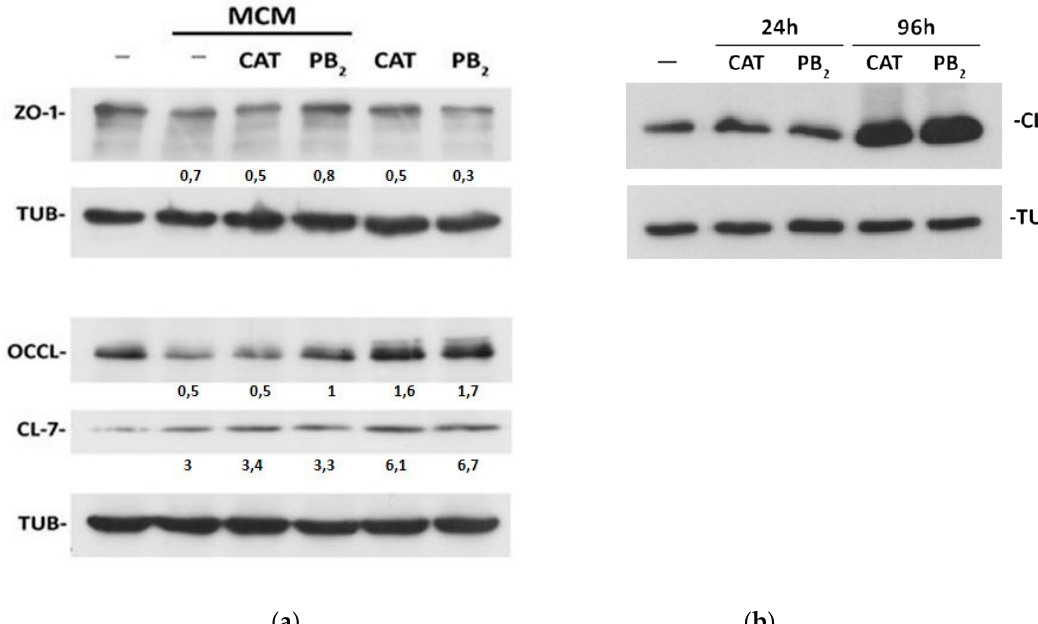
Figure 2. Expression of tight-junctions proteins in Caco-2/HT29-MTX monolayers. Cell monolayers were incubated for 24 h in plain growth medium or with CAT or PB 2 (50 µM), added at the apical side. (a) The basolateral medium was then replaced with MCM or with the medium of Raw264.7 cultures not treated with LPS (See Methods), and the incubation prolonged for further 72 h. Protein were extracted and the expression of ZO-1, occludin and claudin-7 was determined. (b) Proteins were extracted at the end of the 24 h-incubation or after further 72 h of incubation. The expression of claudin-7 was determined. For both a and b, tubulin was used for loading control. The figure reports the results of representative experiments performed twice with comparable results.